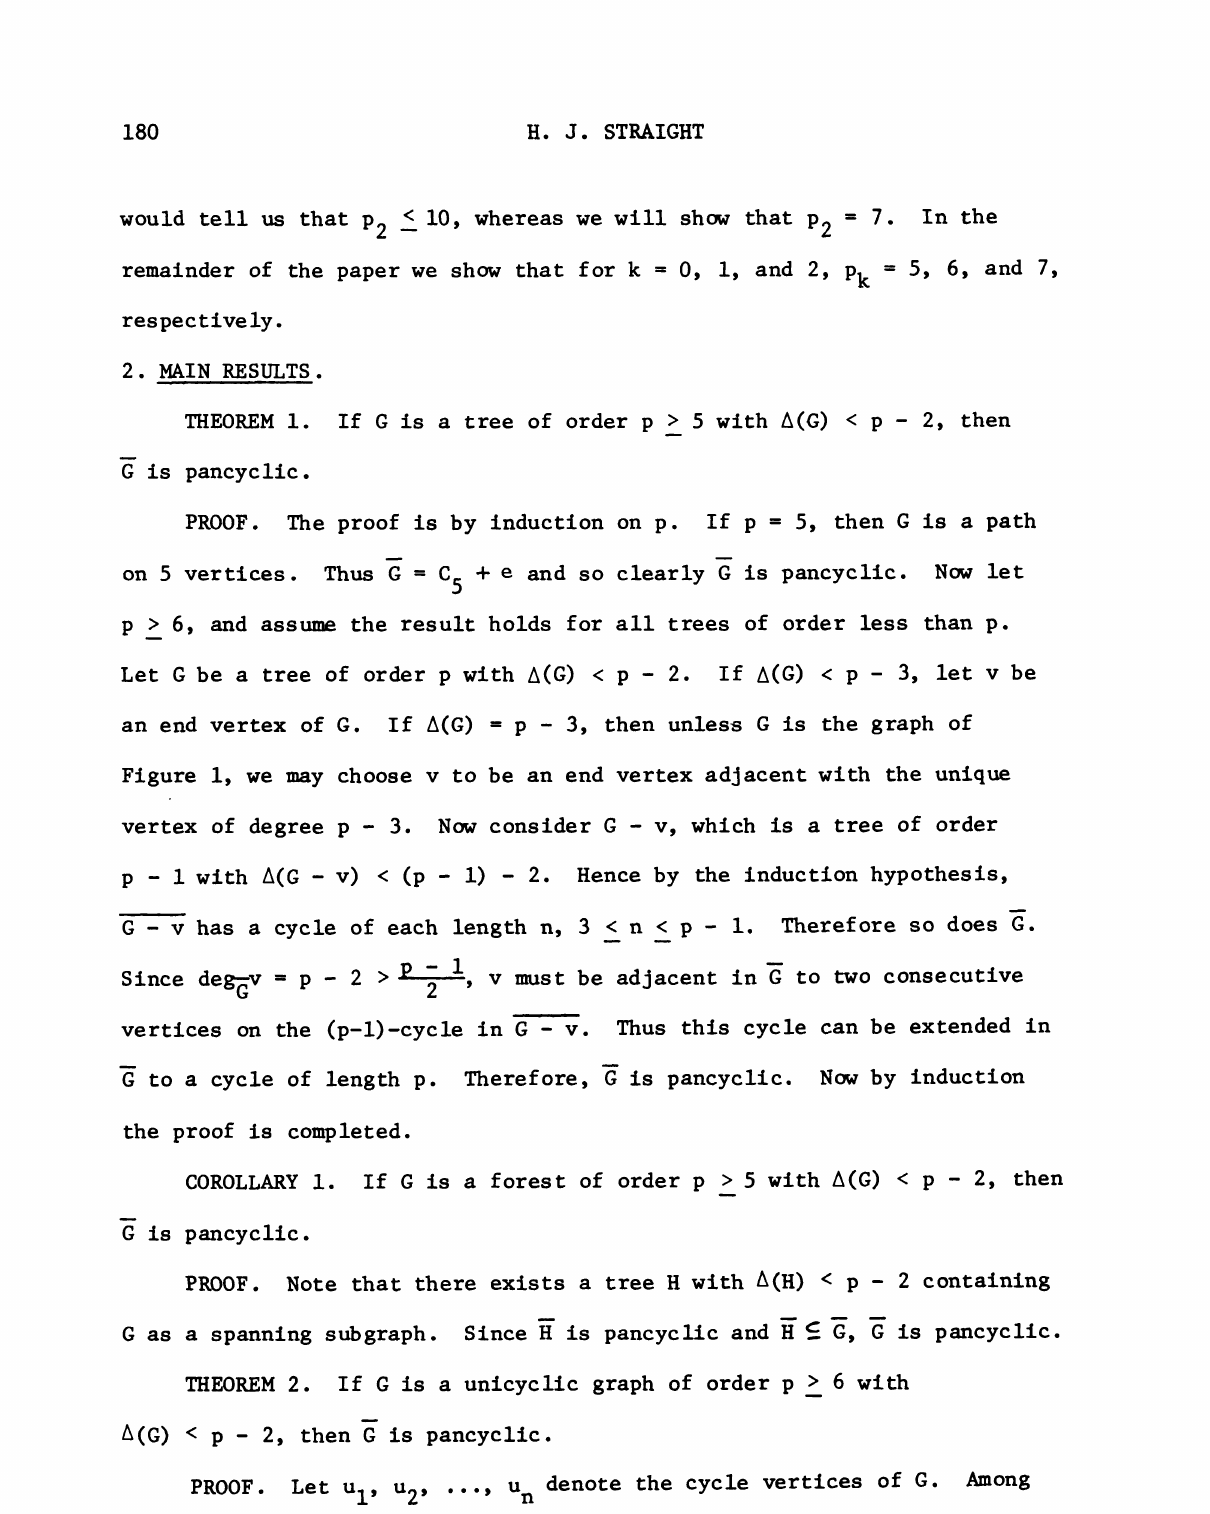
vertex of degree p-